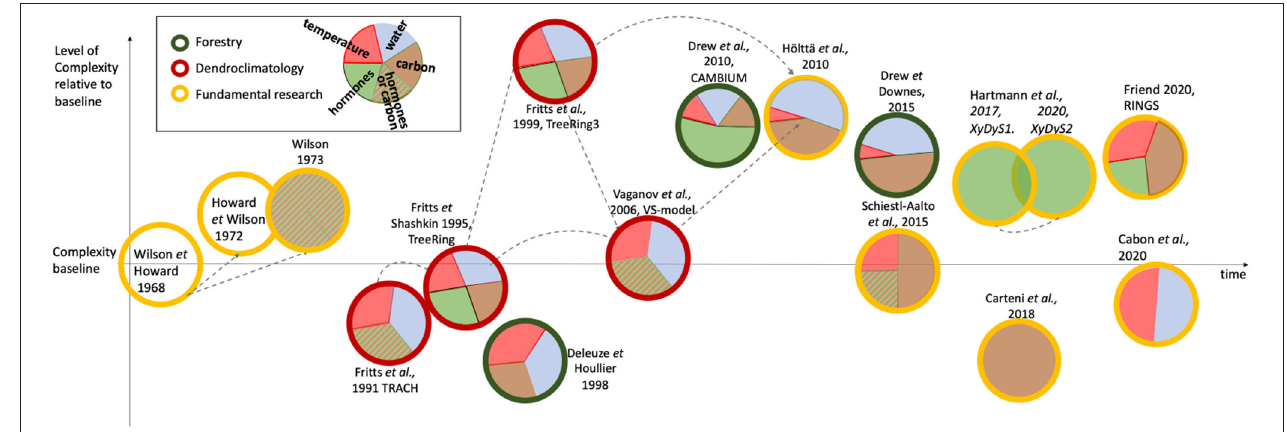
FIGURE 2 | Schematic view of wood formation models over time, their level of complexity, and the environmental/tree-internal influences used within them. Differently colored circles represent the principle focus of the model. Where appropriate, gray dashed arrows highlight structural similarity between models (discussed in more detail in the text). The pie chart proportions represent relative approximate levels of comprehensiveness by which an environmental- or tree-internal- factor (e.g., hormone, carbon) influences model outcome. Striped pie chart components represent a daylength signal, that according to the authors can either be interpreted as carbohydrate availability for growth or a daylength-dependent hormonal signal. Model position on the vertical axis reflects relative complexity. Wilson and Howard (1968) is used as the standard baseline complexity level as, while it considers all cell phases and includes simple transition rules, it does not resolve any environmental or tree-internal regulatory factors. Models below this baseline either contain fewer processes of wood formation e.g., only resolve enlargement and thickening, as in Cartenì et al. (2018), or do not resolve other aspects on wood formation e.g., Deleuze and Houllier (1998) do not resolve a cell undergoing all developmental stages, but assume that it matures within one time step ( = 1 week). Some models are integrated into single-tree models (e.g., Fritts et al., 1999; Hölttä et al., 2010; Schiestl-Aalto et al., 2015), but this is not considered in the complexity ranking. Models considered of high complexity either regard all cellular processes and transitions, as well as environmental influences with significant detail (e.g., Fritts et al., 1999), resolve more than one cell type (e.g., Drew et al., 2010), or resolve some processes at such levels of detail that for stability reasons they must run on a very small time step (i.e., 1 s, e.g., Hölttä et al.,